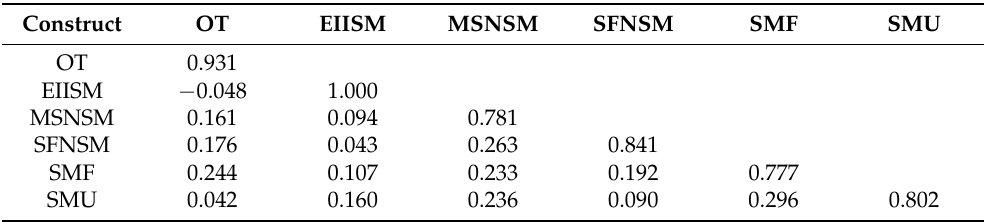
Table 3. Discriminant validity analyses